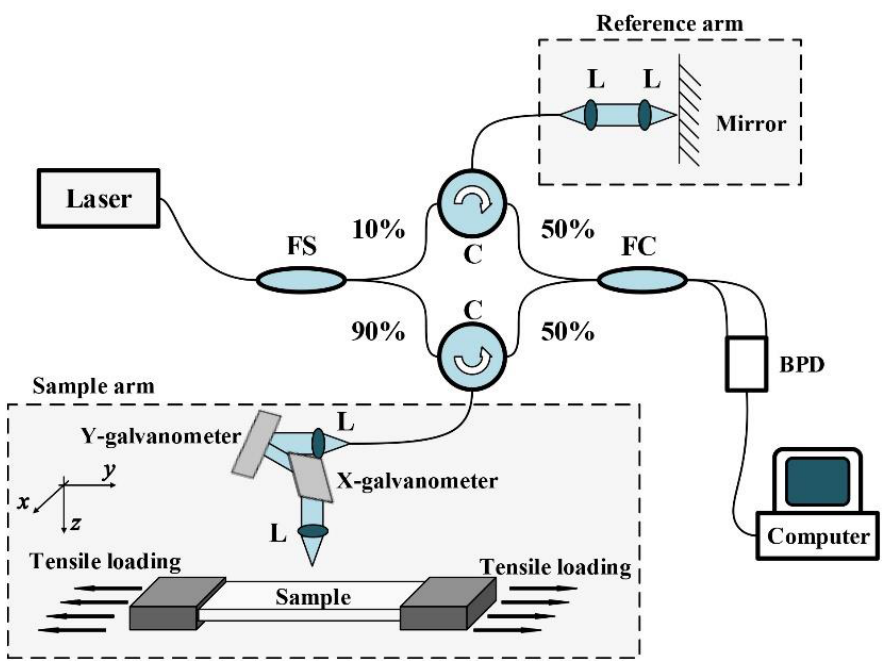
Figure 1. Schematic diagram of OCE system. FS, fiber splitter. FC, fiber coupler. BPD, balanced photodetector. L, lens. C, circulator.